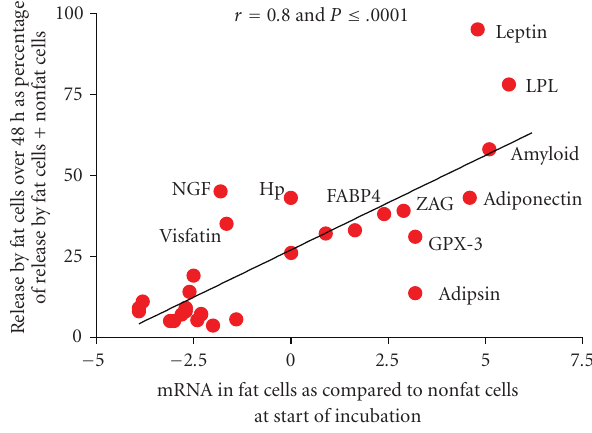
Figure 1: The correlation between releases of 30 adipokines over 48 hours incubation by fat cells isolated from human adipose tissue as compared to gene expression of these adipokines at the start of the incubation. The release data are from Table 1 and expressed as release by fat cells as % of that by fat cells plus nonfat cells over 48 hours. The data for mRNA are derived from those shown in Table 2 except that they are plotted as the Δ Cp for the di ff erence between mRNA in fat cells and nonfat cells instead of the ratios, which are derived from the Δ Cp values. Data are not included for resistin, CRP and IL-18 since release by fat cells was below the sensitivity of the assays and mRNA was not measured for MIF, HGF, VEGF, and